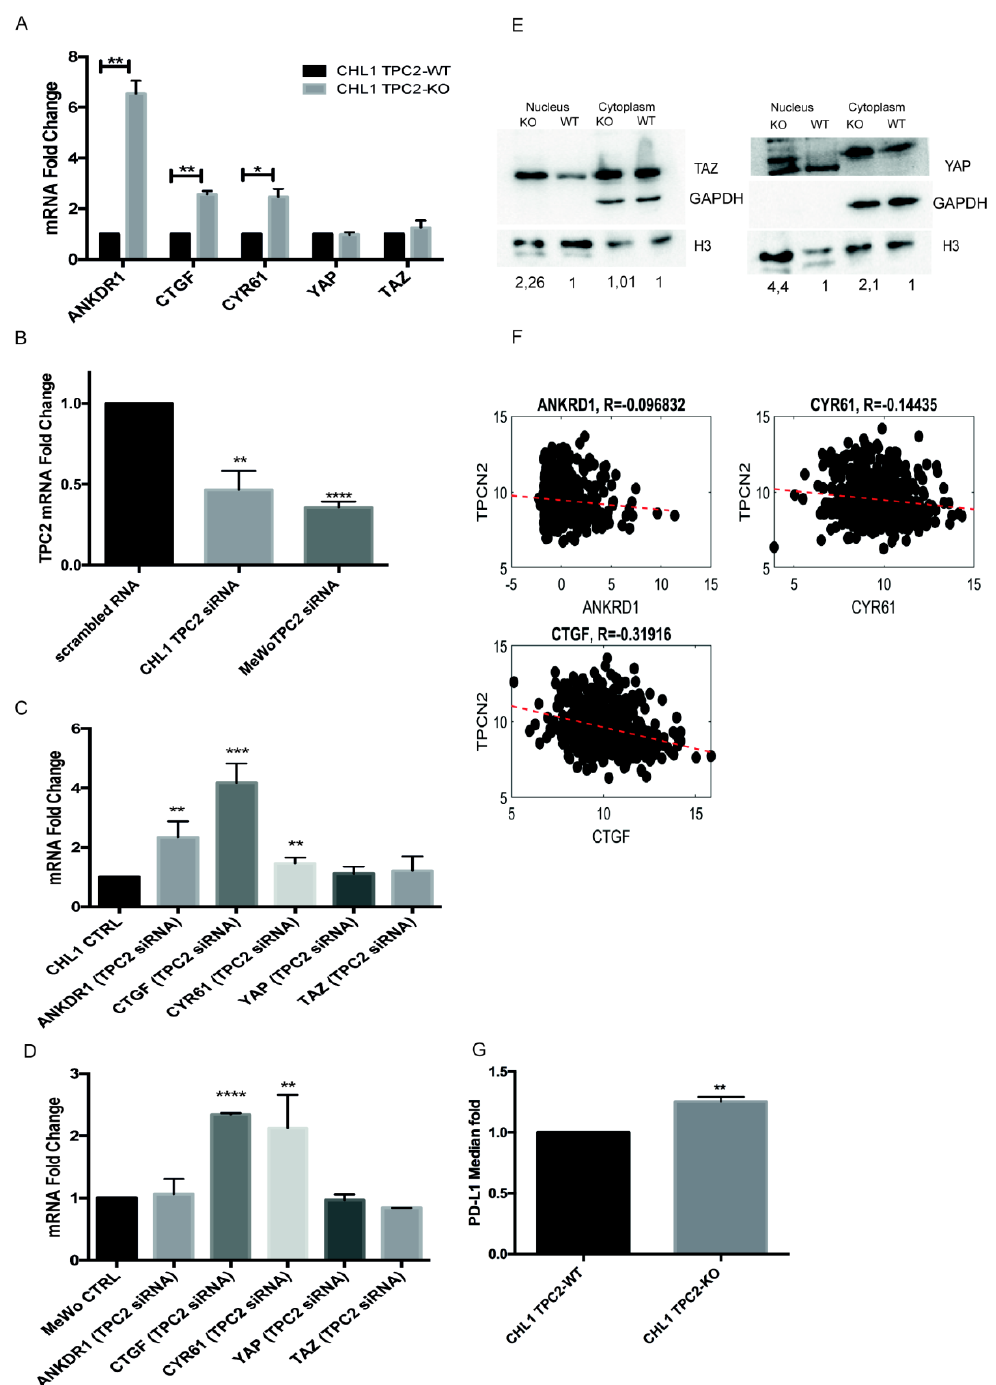
Figure 4. TPC2 KO and silencing induces YAP / TAZ target genes. ( A ) qPCR analysis of YAP / TAZ target genes in CHL1 WT and TPC2 KO cells. H3 was used as an internal control. ( B ) TPC2 transient inhibition after 24 h from CHL1 transfection. ( C ) qPCR analysis of YAP/TAZ target genes after the transient silencing of TPC2 in CHL1 cells. Glyceraldehyde 3-phosphate dehydrogenase (GAPDH) was used as an internal control. ( D ) qPCR analysis of YAP/TAZ target genes after the transient silencing of TPC2 in the MeWo cell line. GAPDH was used as an internal control. ( E ) Nucleus–cytoplasm extraction to analyse YAP and TAZ nuclear localization. ( F ) Correlation between TPCN2 and CTGF, CYR61, and ANKRD1 in human SKCM (for the p -value see Table S1). ( G ) Flow cytometric detection of PD-L1 in CHL1 WT and TPC2 KO cells after IFN- γ induction. Data in bar charts represent the mean ± s.e.m. of three independent experiments (* p < 0.05; ** p < 0.01; *** p < 0.001; **** p <